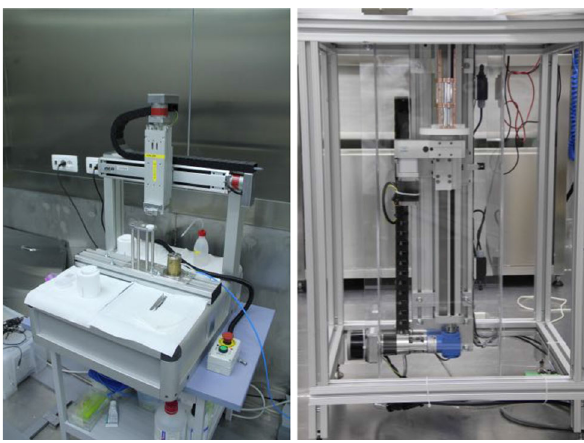
Fig. 11 Photos of the two working areas inside the cleanroom. On the left is shown the station were the Ge-NTD thermal sensors are glued to the absorbers, and on the right is shown the area where the tower are assembled